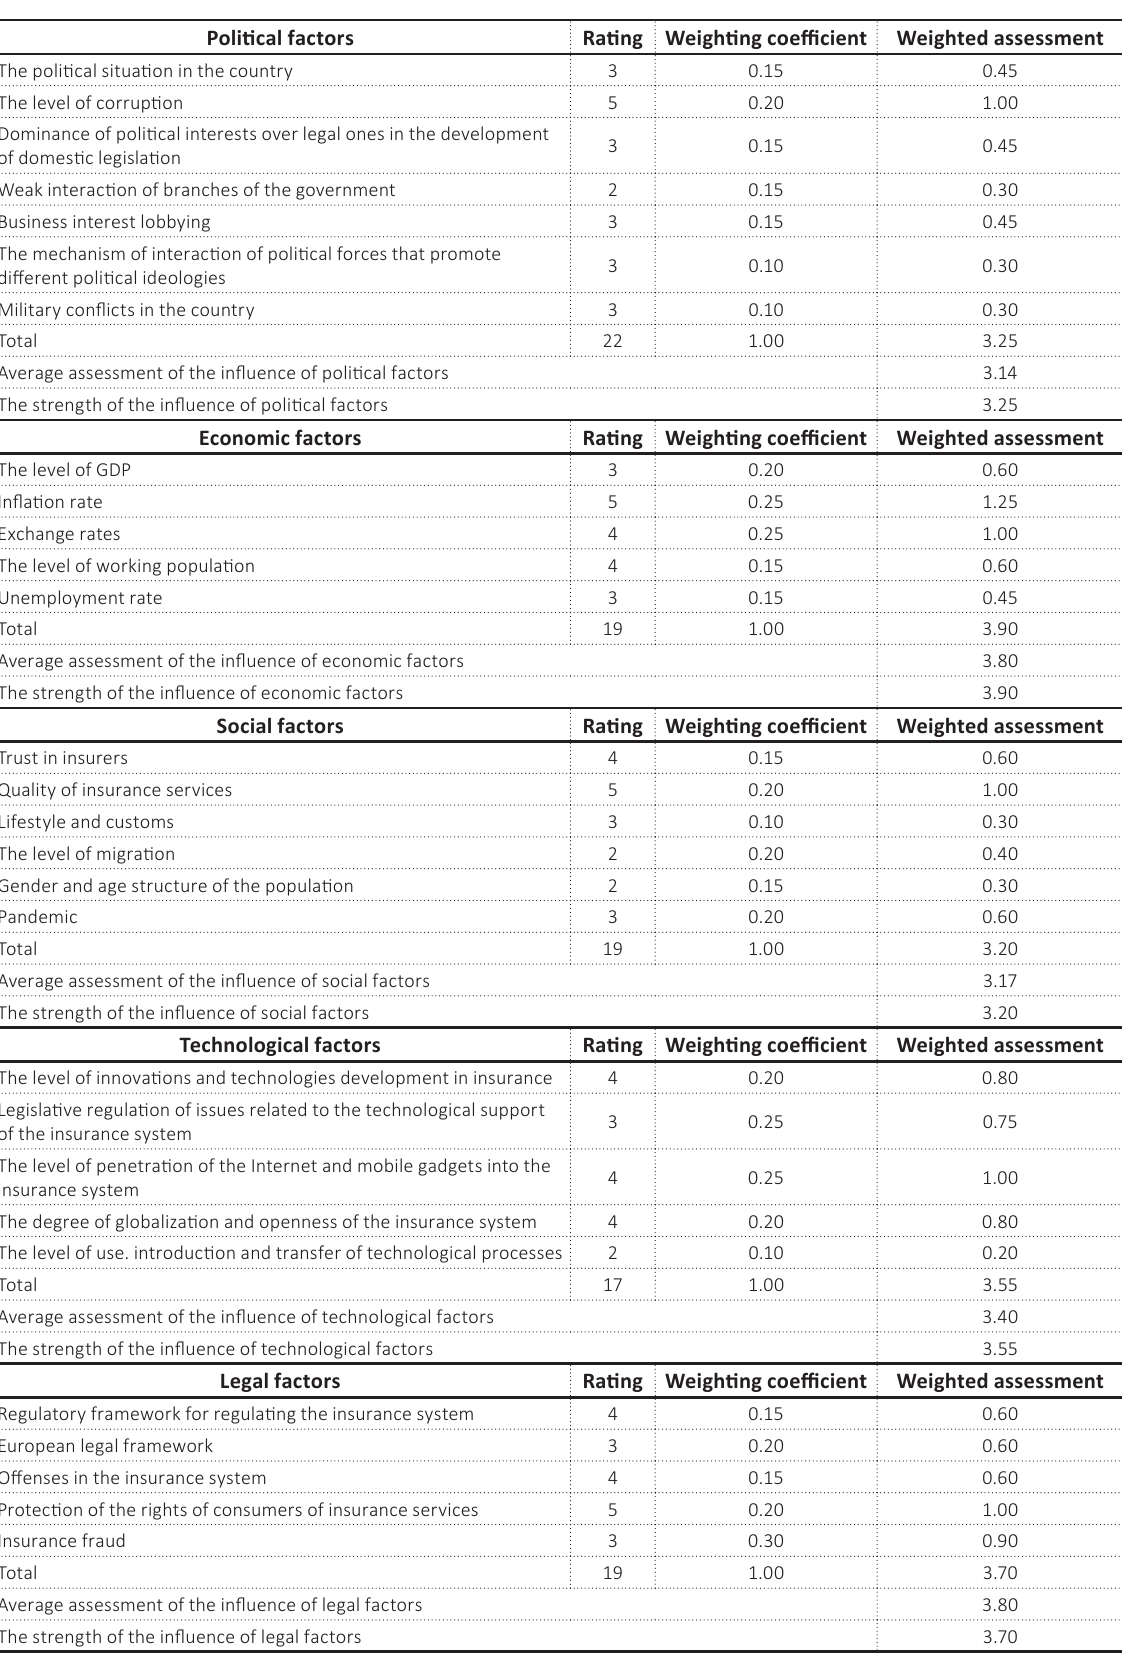
Table 1. PESTL analysis indicators of the insurance system development in Ukraine Political factors Rating Weighting